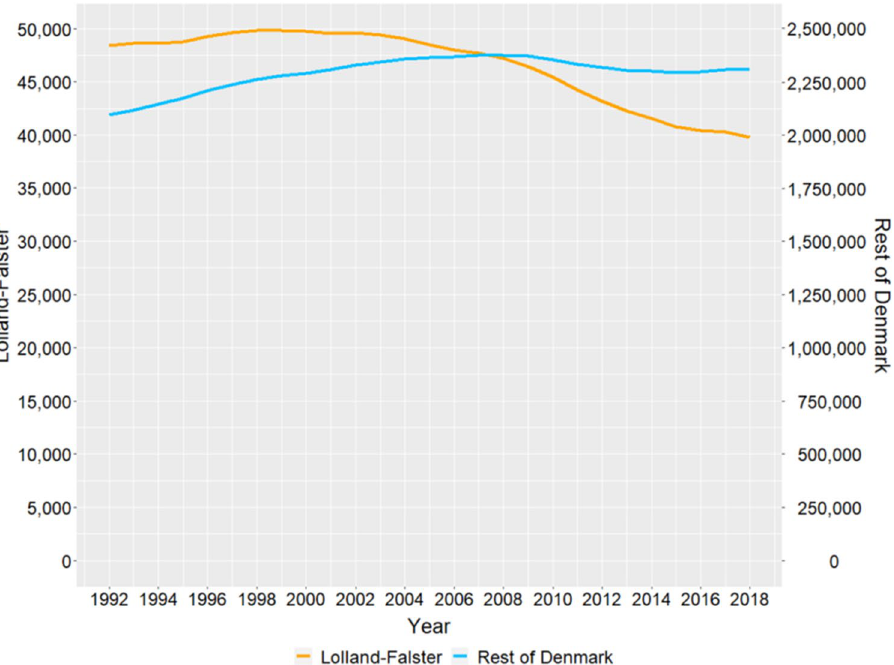
Figure 1. Mid-year population number for people aged 30–64 years living in Lolland-Falster and in the rest of Denmark by year,